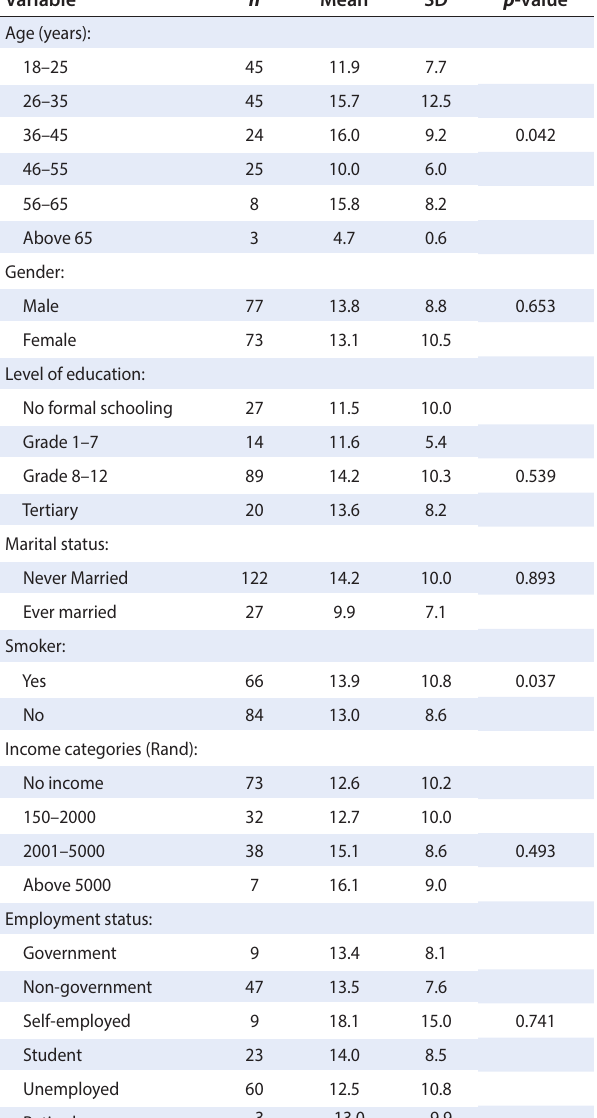
Table 4: Distribution of mean frequency of binge drinking by socio- demographic variables using ANOVA Variables